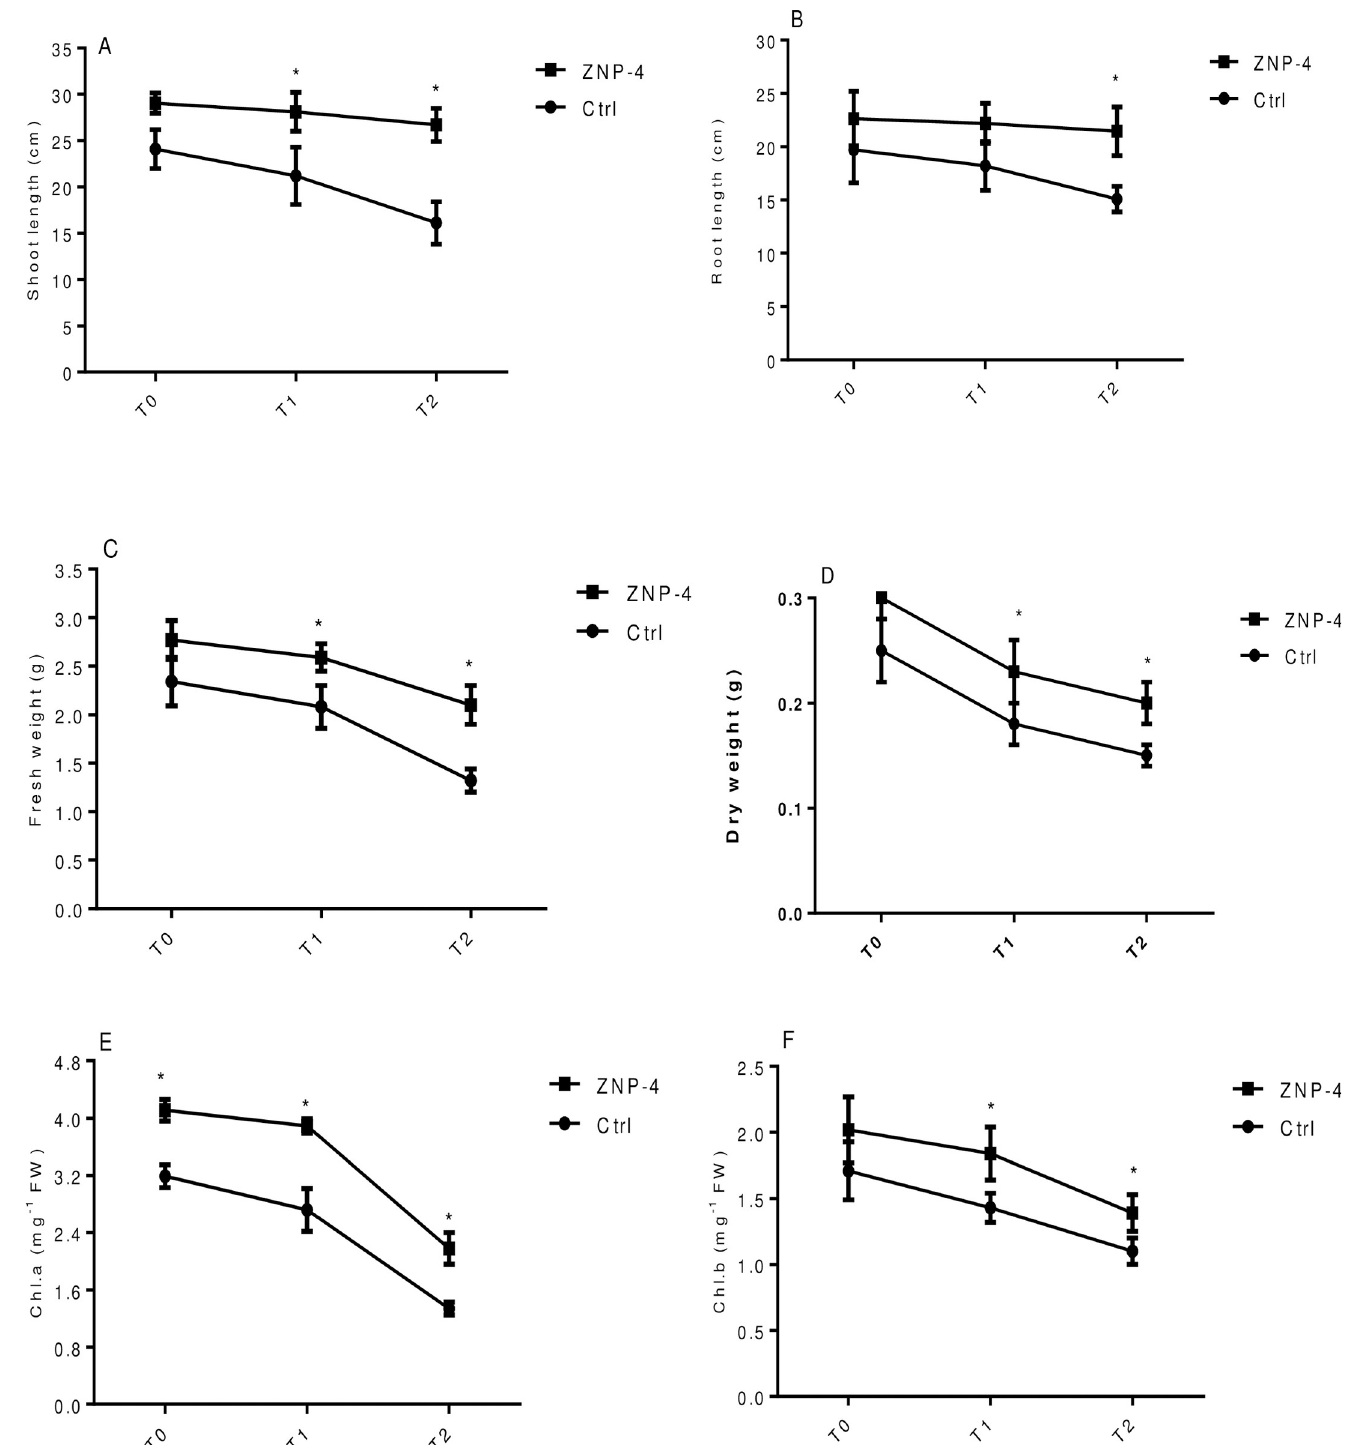
Fig 5. Effect of inoculation with bacterium ZNP-4 on plant growth and chlorophyll contents under different metal (ZnSO 4 ) concentrations, (A) shoot length (B) root length (C) fresh weight (D) dry weight (E) chlorophyll a (F) chlorophyll b. Values are mean ± SD of triplicate sets (n = 15). � represent the significant difference as compared to respective control according to Ducan’s multiple range test (p =